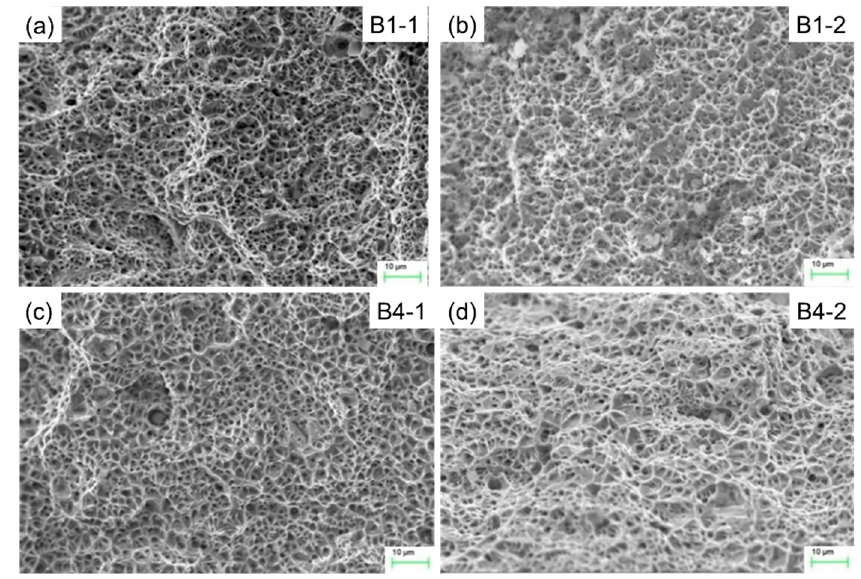
Figure 17. The micro-fracture surface morphologies in welds of SSRT specimens: ( a ) B1-1, ( b ) B1-2, ( c ) B4-1 and ( d ) B4-2.